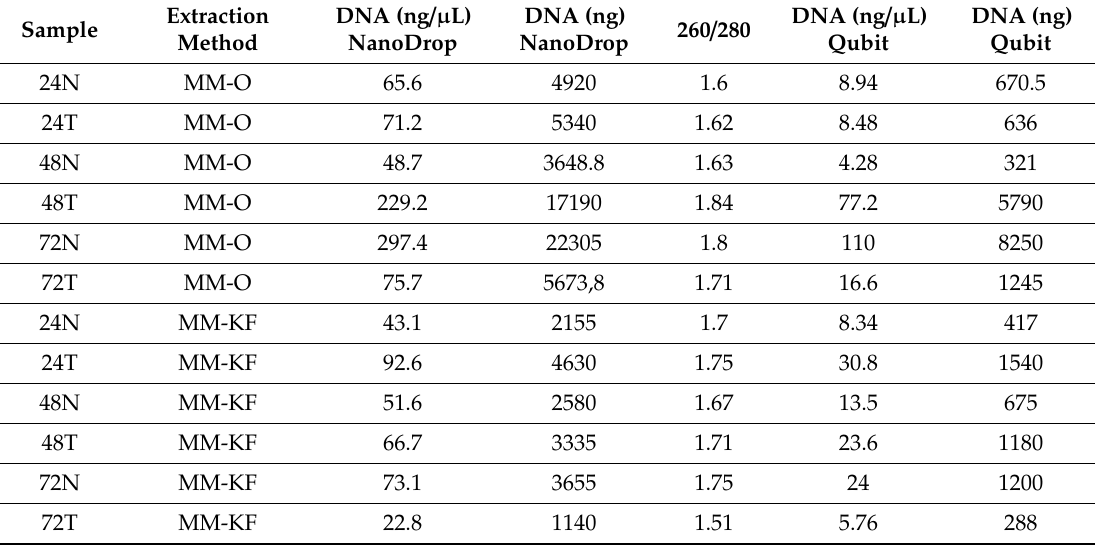
Table 3. Quantity evaluation using spectrophotometric (NanoDrop) and fluorometric (Qubit) assays. OMNIA Prima (MM-O) vs. MM King Fisher (MM-KF).